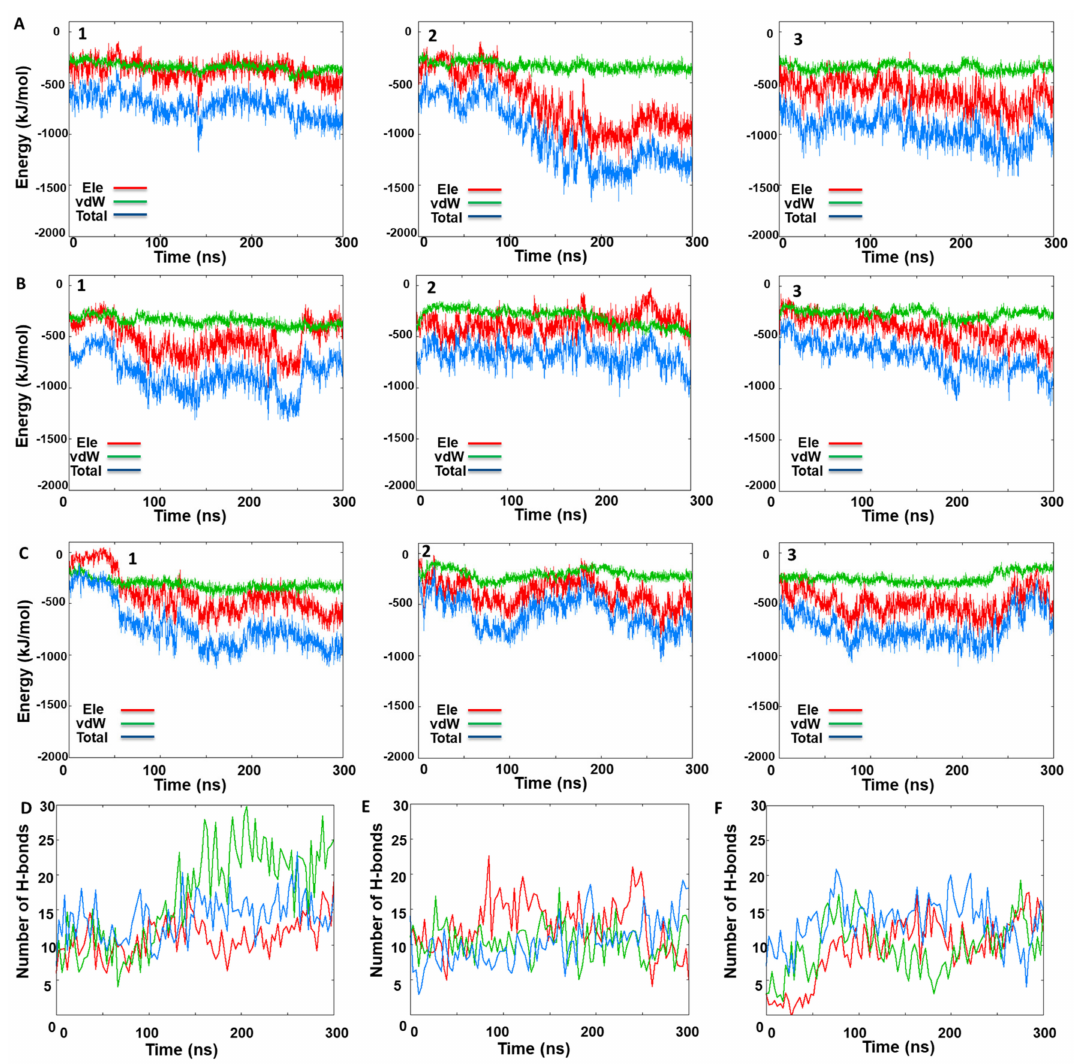
Figure 6. IRE1 face-to-face dimer MD simulations. Time-dependent interaction energy profiles for monomer A with monomer B during the three MD simulation replicas of ( A ) native face-to-face crystal dimer (PDB code: 3P23), ( B ) KIRA-docked face-to-face dimer (PDB code: 3P23), ( C ) protein–protein docked pose of PDB 4U6R in the face-to-face dimer form. Hydrogen bond analysis between monomers A and B during three MD replicas for ( D ) native face-to-face crystal dimer (PDB code: 3P23), ( E ) KIRA-docked face-to-face dimer (PDB code: 3P23), ( F ) protein–protein docked pose of PDB 4U6R in the face-to-face dimer